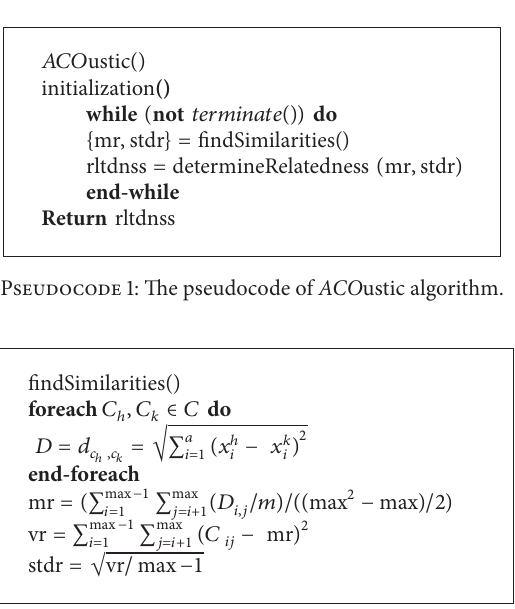
Pseudocode 2: The pseudocode of findSimilarities algorithm.